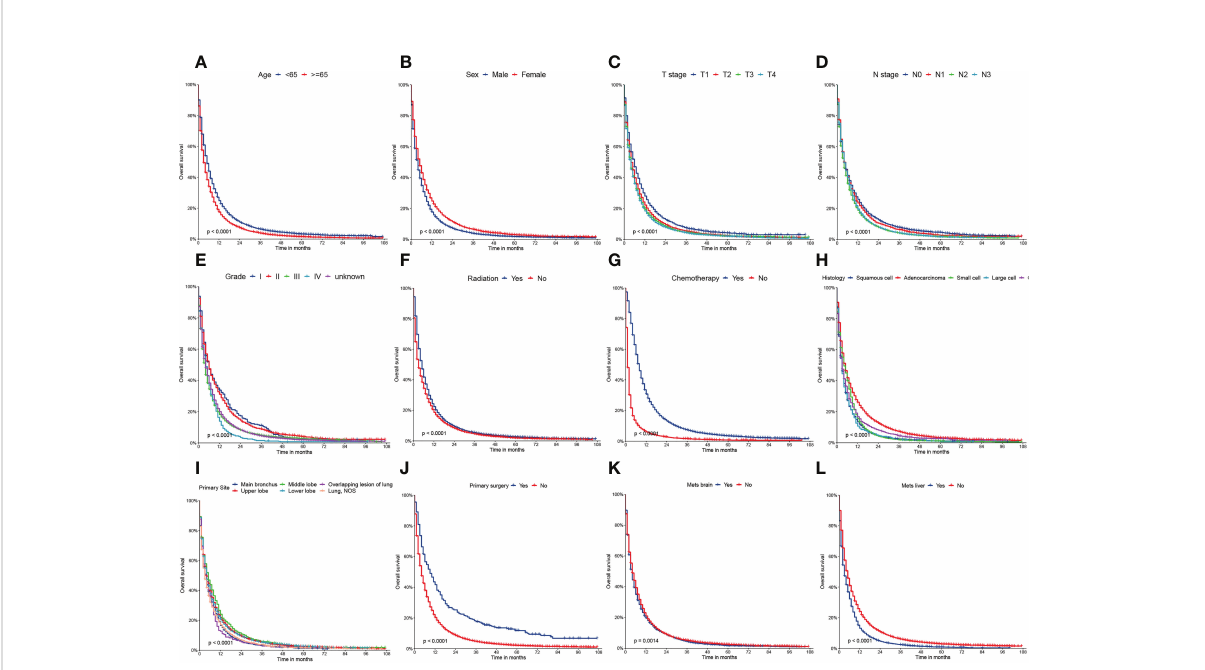
FIGURE 2 Kaplan – Meier curves of the overall survival (OS) factors: (A) age, (B) sex, (C) T stage, (D) N stage, (E) grade, (F) radiation, (G) chemotherapy, (H) histology, (I) primary site, (J) primary surgery, (K) mets-brain, and (L) mets-liver.